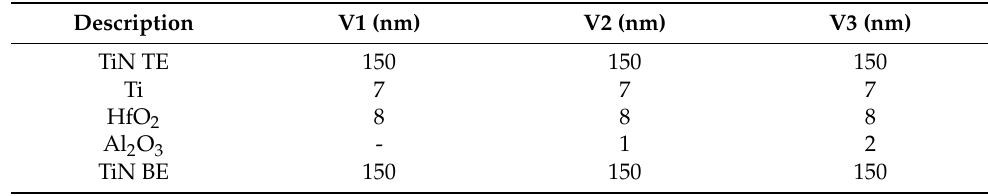
Figure 1. TEM cross-section of an integrated 1T–1R memristor device, fabricated in 130 nm CMOS technology. The inset micrograph illustrates the memristor module.